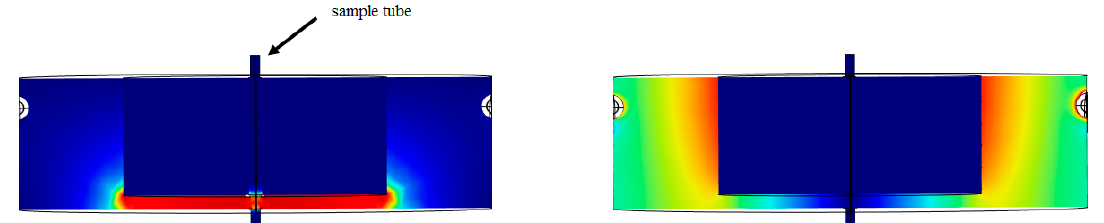
Figure 1. Cross section of a re-entrant microwave cavity, showing the distribution of electric ( a ) and magnetic ( b ) fields; the position of the sample tube within the axial hole.